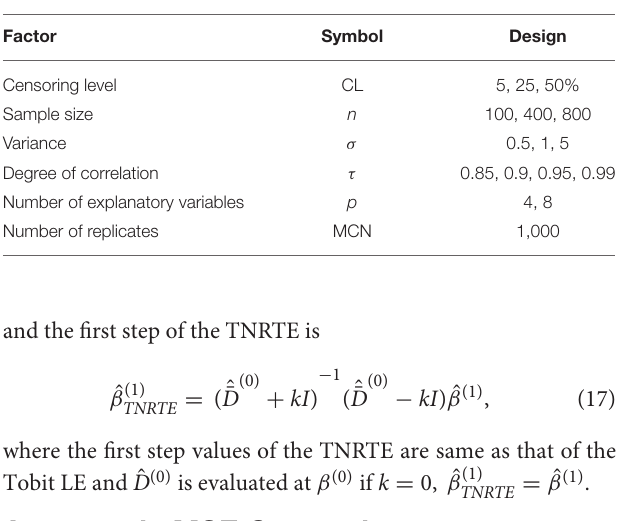
TABLE 1 | Values of factors that are considered in the